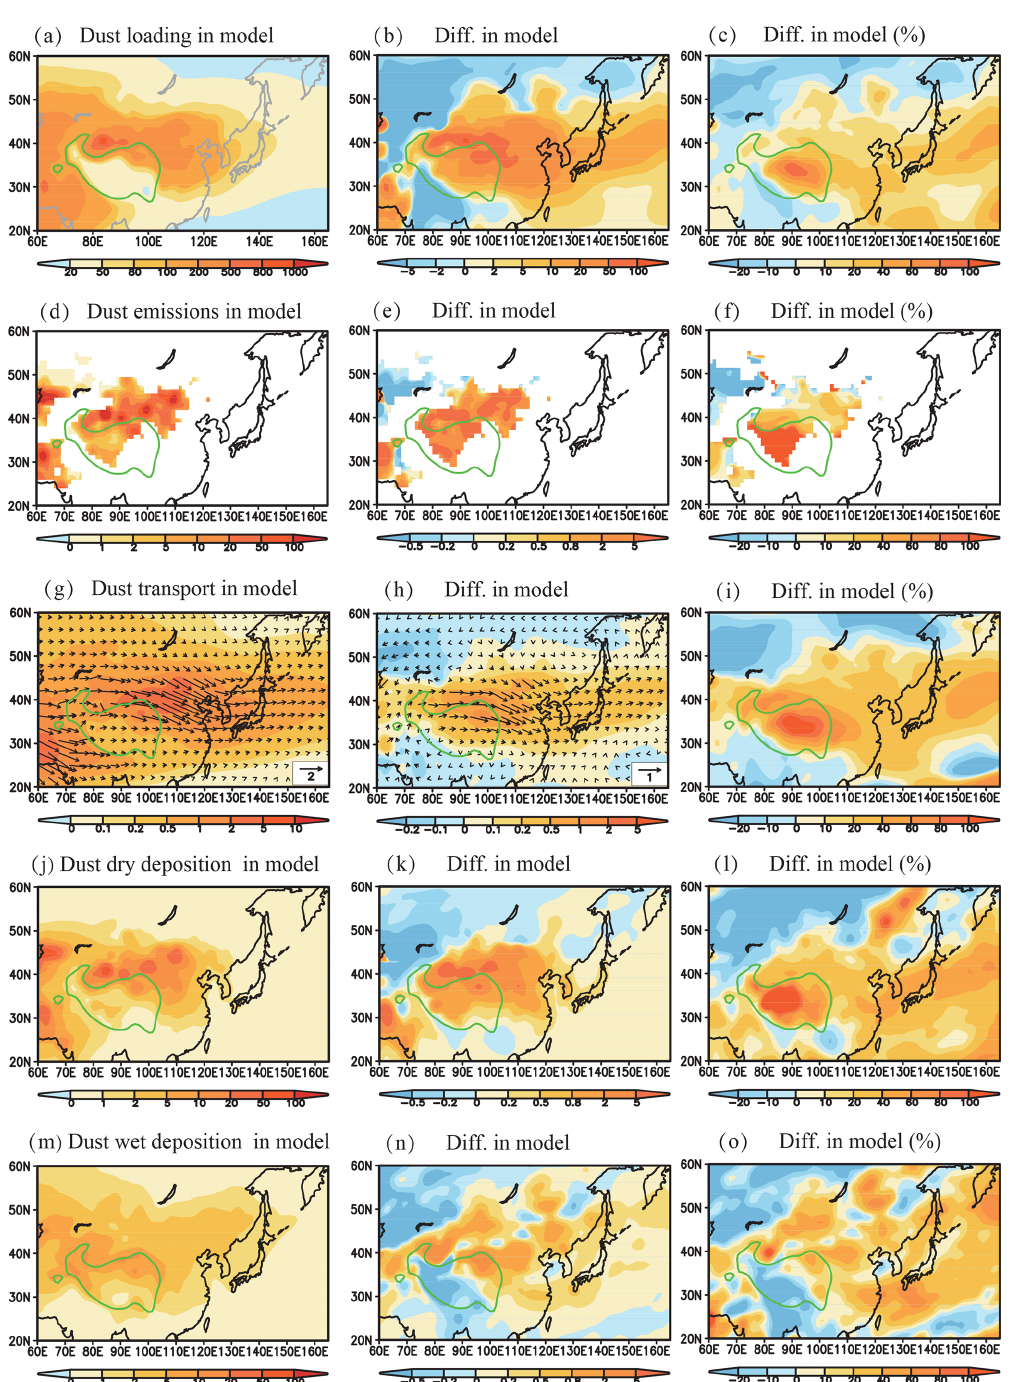
Figure 6. Spatial distribution of the MAM mean values for 30 model years (left column), absolute differences between the strongest and weakest TPSH years (strongest–weakest) (middle column), and the corresponding relative differences (right column) in (a, b, c) dust loading (mgm − 2 ), (d, e, f) dust emissions (gm − 2 per season), (g, h, i) dust transport (gm − 1 s − 1 ), (j, k, l) dust dry deposition (gm − 2 per season), and (m, n, o) dust wet deposition (gm − 2 per season). The green-contour area indicates the plateau above